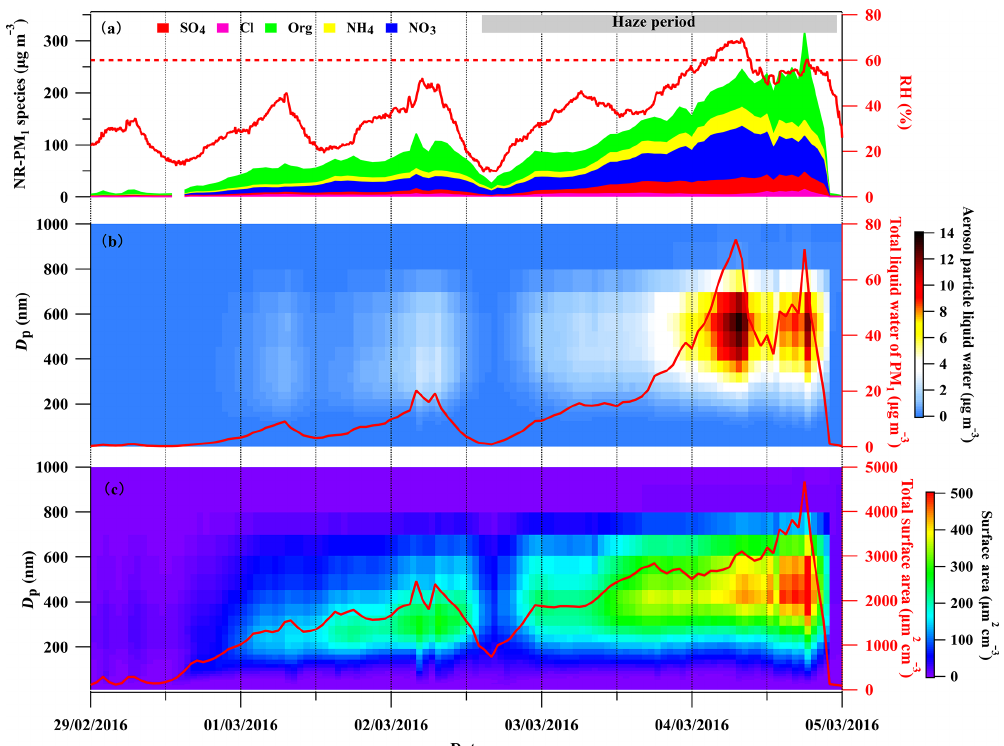
Figure 1. The time series of (a) NR-PM 1 chemical composition measured by the HR-ToF-AMS and ambient RH (solid red line), (b) size- segregated aerosol particle liquid water and the total mass concentration of liquid water with an aerodynamic diameter smaller than 1µm (solid red line), and (c) size-segregated aerosol particle surface area and total aerosol particle surface area without considering particle hygroscopic growth during 29 February to 5 March 2016.